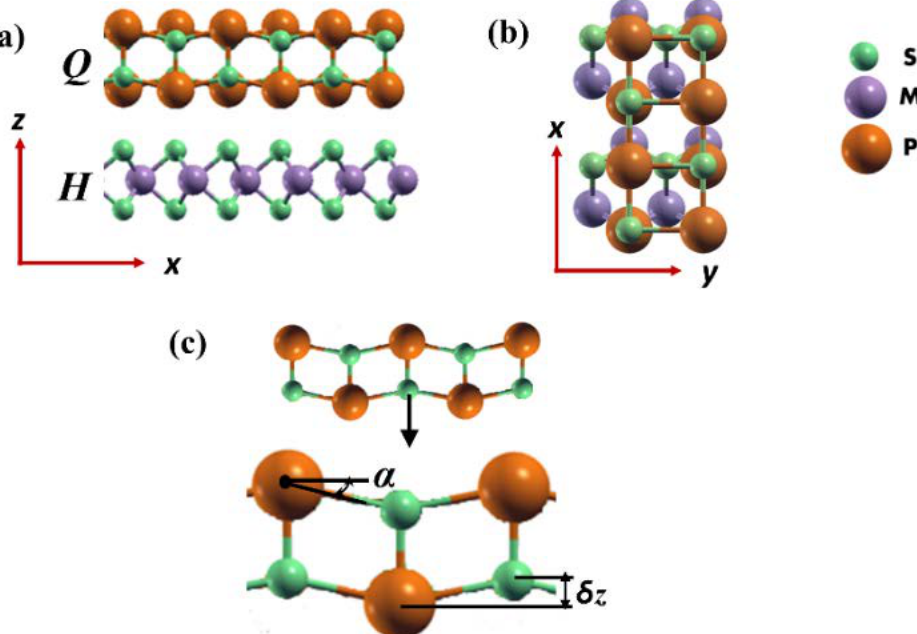
Figure 1. ( a ) Side view (c-axis vertical), ( b ) top view of the MoS 2 -PbS heterostructure, composed of H (i.e., MoS 2 monolayer), and Q (i.e., PbS bilayer) layers. ( c ) The buckling parameters of the Q (PbS-like bilayer) layer. Color code: Mo (grey), Pb (orange), and S (green).